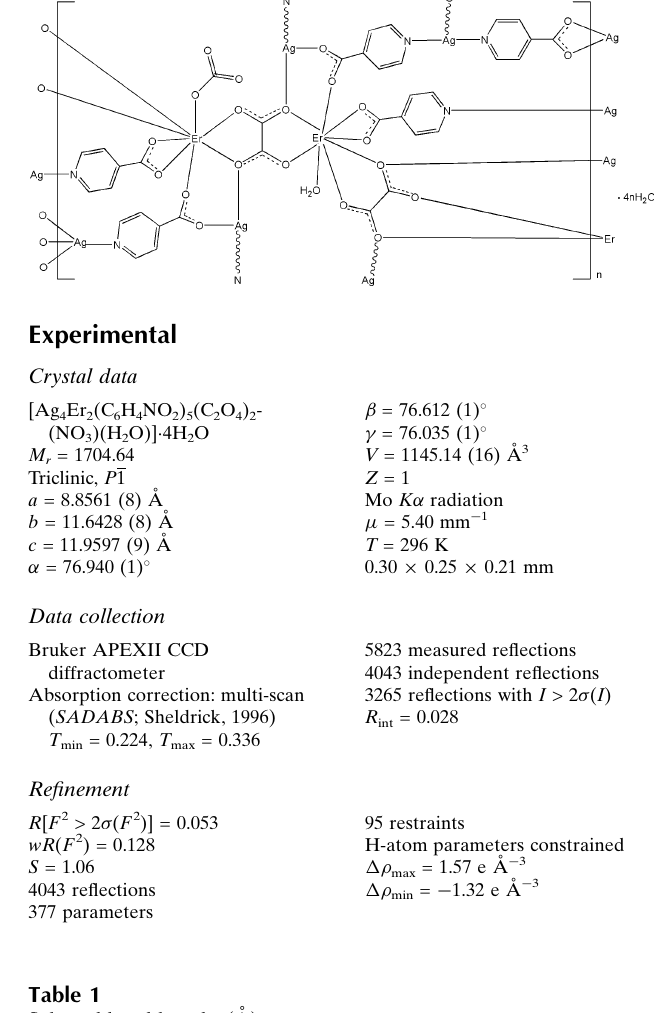
Selected bond lengths (A˚ ).